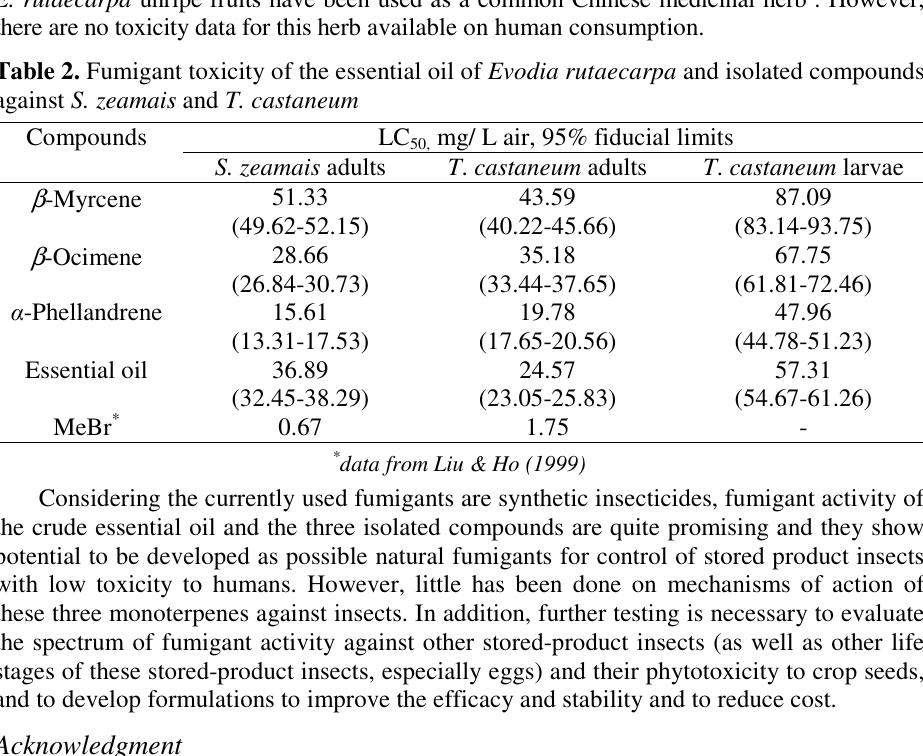
Table 2. Fumigant toxicity of the essential oil of Evodia rutaecarpa and isolated compounds against S. zeamais and T. castaneum